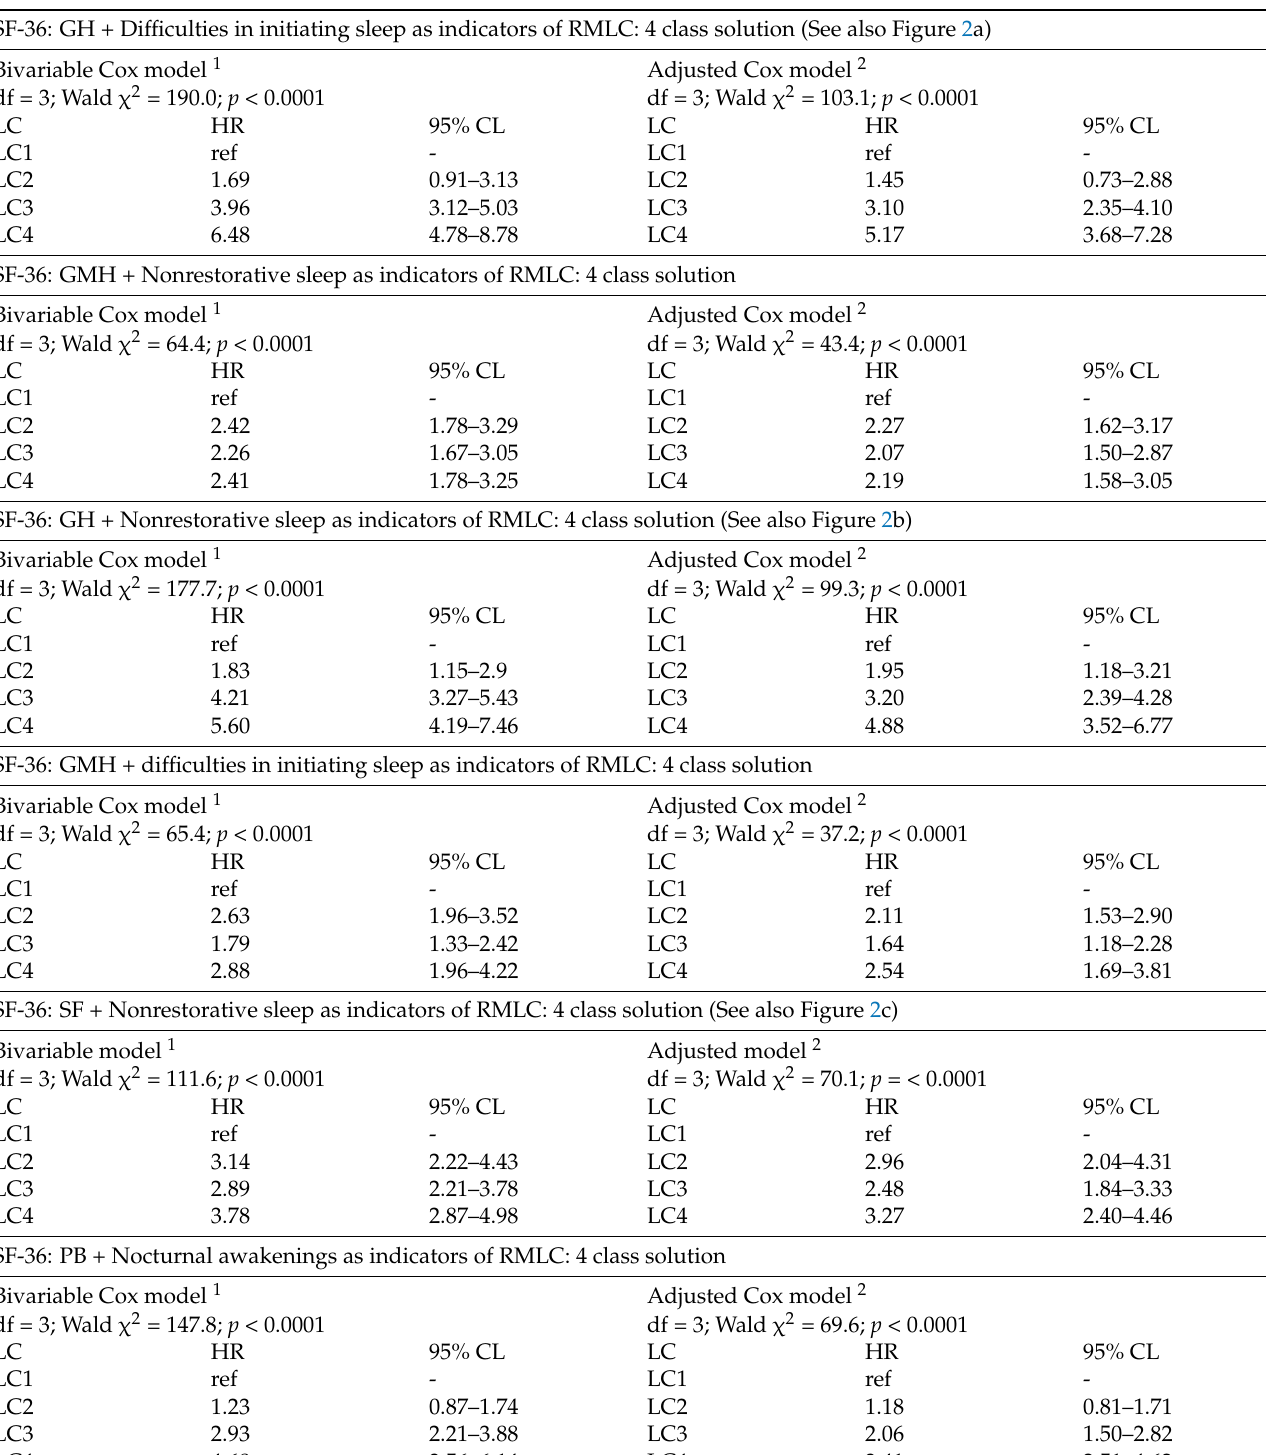
Table 4. Selected Cox models using RMLCA model based classification as a statistical predictor of premature retirement events ( n = 363 events, ref.= reference group, latent class 1,